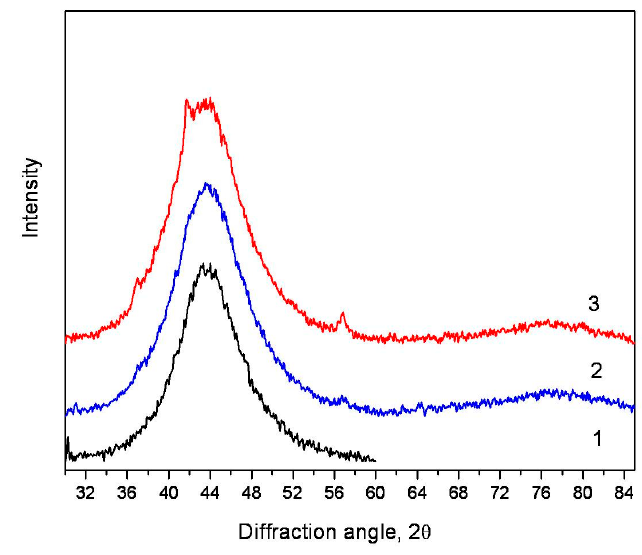
Figure 6. X-ray di ff raction patterns of initial (1) and deformed samples of Zr 55 Cu 30 Al 10 Ni 5 alloy (2–1 rotation, 3–10 rotations) (Co K α ).